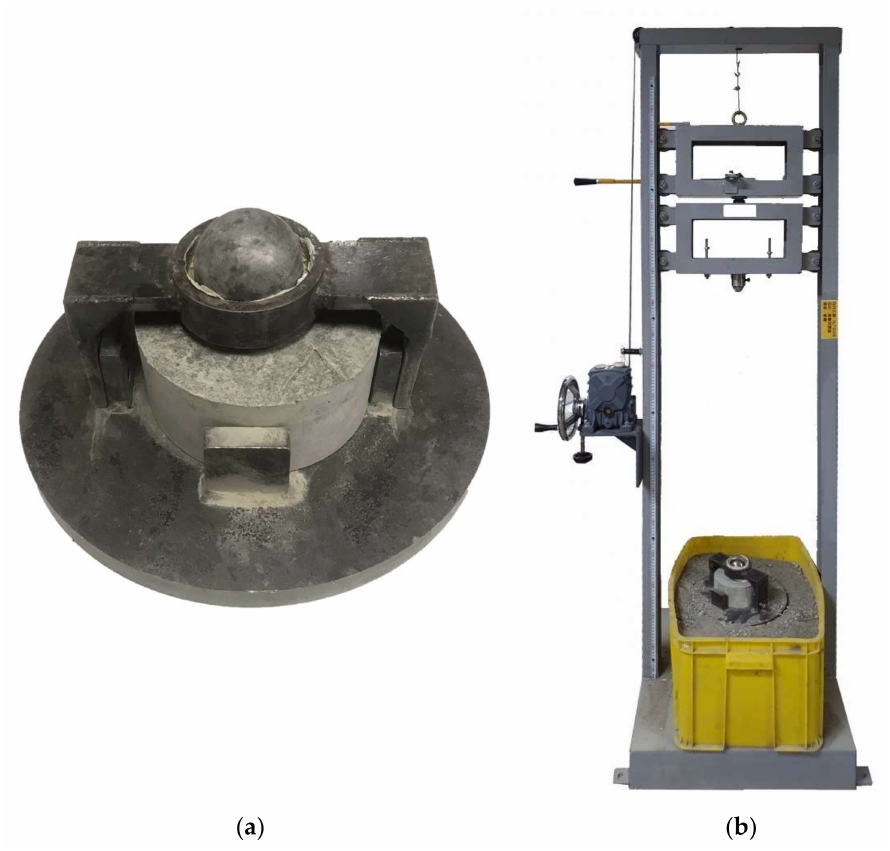
Figure 3. Free-fall impact test: ( a ) test equipment and KFRC specimen; ( b ) test